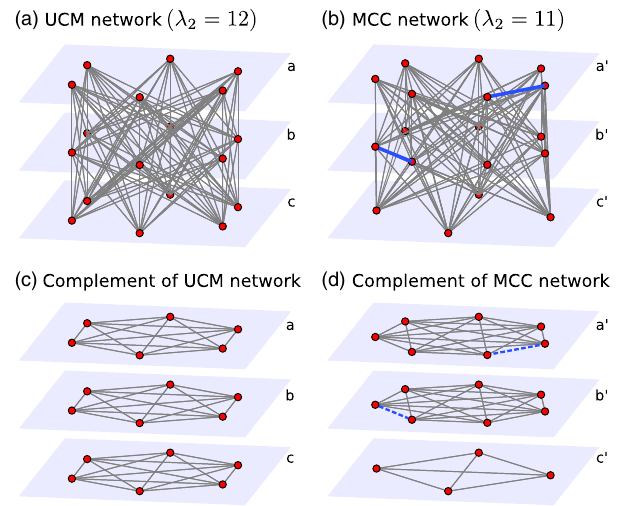
FIG. 2. UCM and MCC networks with n ¼ 18 nodes. (a) The UCM network with l ¼ 3 groups (labeled a, b, and c) of k ¼ 6 nodes each. All pairs of nodes belonging to different groups are connected, while all pairs within the same group are not connected, leading to a total of m ¼ k 2 l ð l − 1 Þ = 2 ¼ 108 links. (b) An MCC network constructed with the same number of nodes but with one fewer link ( m ¼ 107 ) and groups of unequal sizes (labeled a 0 , b 0 , and c 0 , and of sizes 7, 7, and 4, respectively). Note that in this case some nodes within the same group are connected (as indicated by solid blue lines). (c) The complement of the UCM network in (a), which has l k ð k − 1 Þ = 2 ¼ 45 links. In the complement, a node pair is connected if they are in the same group, and not connected if they are from different groups. (d) The complement of the MCC network in (b), which has 46 links. Since it has one more link than what can be accommodated by three isolated groups of size 6 [as in (c)], the minimum possible size of the largest component in the complement equals 7 in this case. Note that groups a 0 and b 0 have missing links (indicated by dashed blue lines), which correspond to the links within groups a 0 and b 0 in (b). The required increase in the size of the largest component in the complement forces λ 2 to decrease by